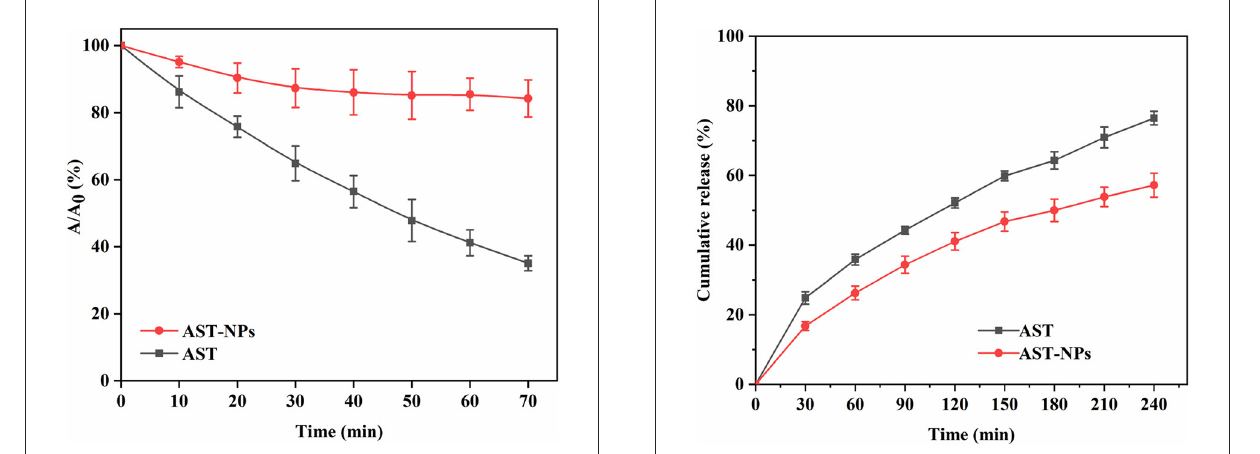
FIGURE7 In vitro release profiles of free AST and AST-NPs.